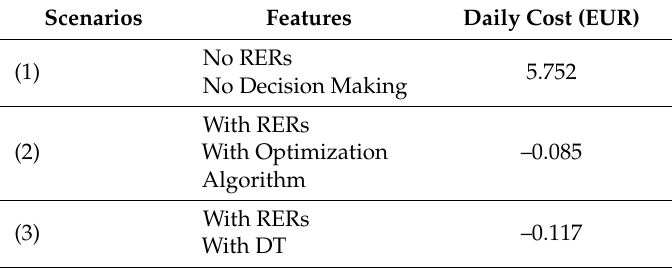
Table 5. Cost calculation during the proposed case